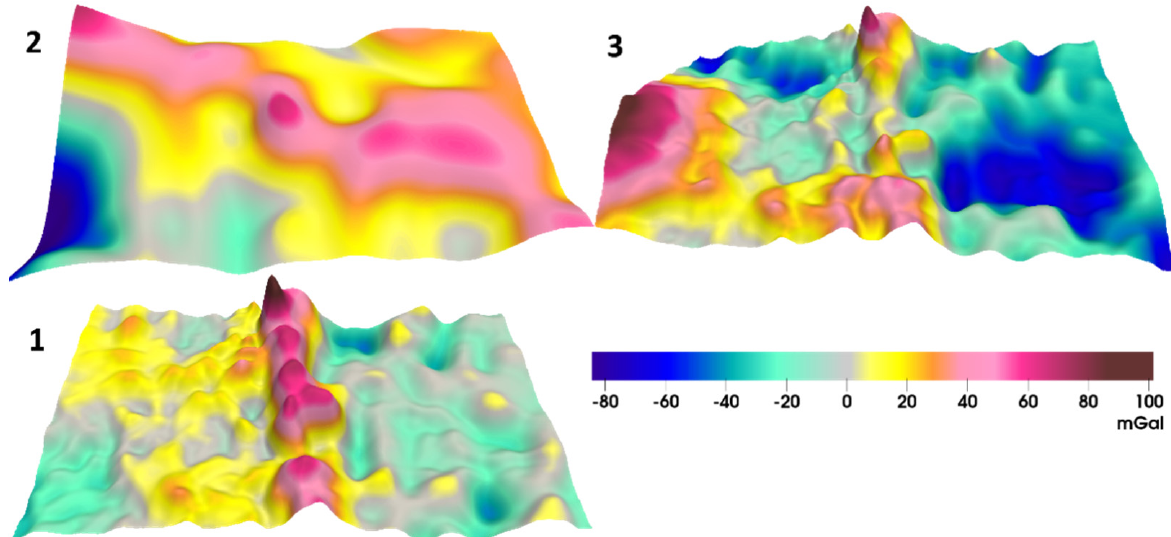
Figure 5. Gravity field: (1) observed; (2) initial model; and (3) difference. In order to evaluate the acceleration of calculations using the graphics accelerator (GPU) in comparison with the central processing unit (CPU), a series of field upward recalculations was carried out with different sampling grid resolutions. It should be noted that in the calculations, the discretization parameters of the grids of the recalculated and resulting fields were the same. Discretization parameters and computation times are shown in Table 1. The calculations were carried out with 24 cores (48 threads) of the AMD EPYC 7451 processor with a clock frequency of 2.9 GHz and one GPU AMD Radeon VII (Vega 20). Figures 6 and 7 show the corresponding graphs of